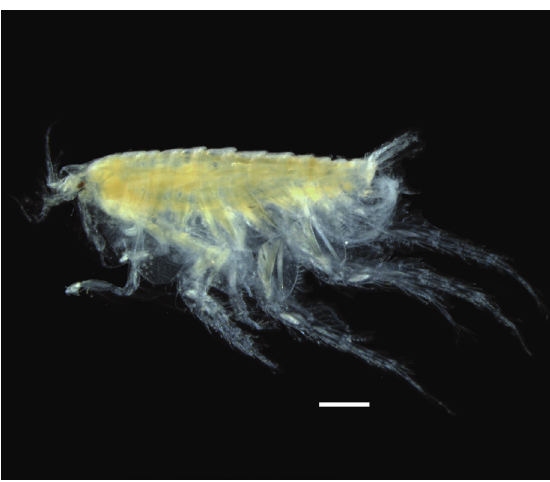
Figure 12 - Puelche longidactylus sp. nov. Female, MNRJ 28985: Habitus. Scale = 0.5